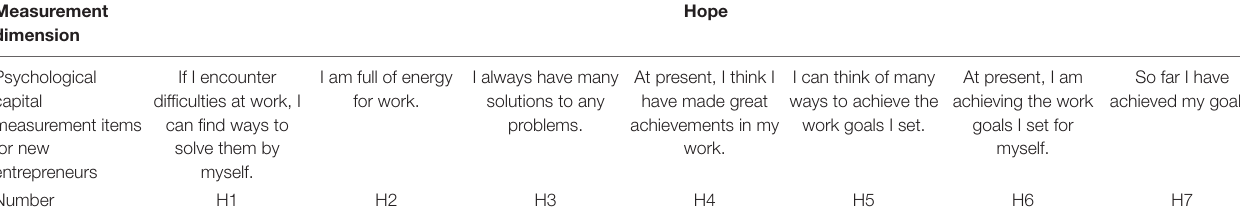
TABLE 1 | Items of the sub-scale measuring psychological capital of new entrepreneurs. Measurement dimension